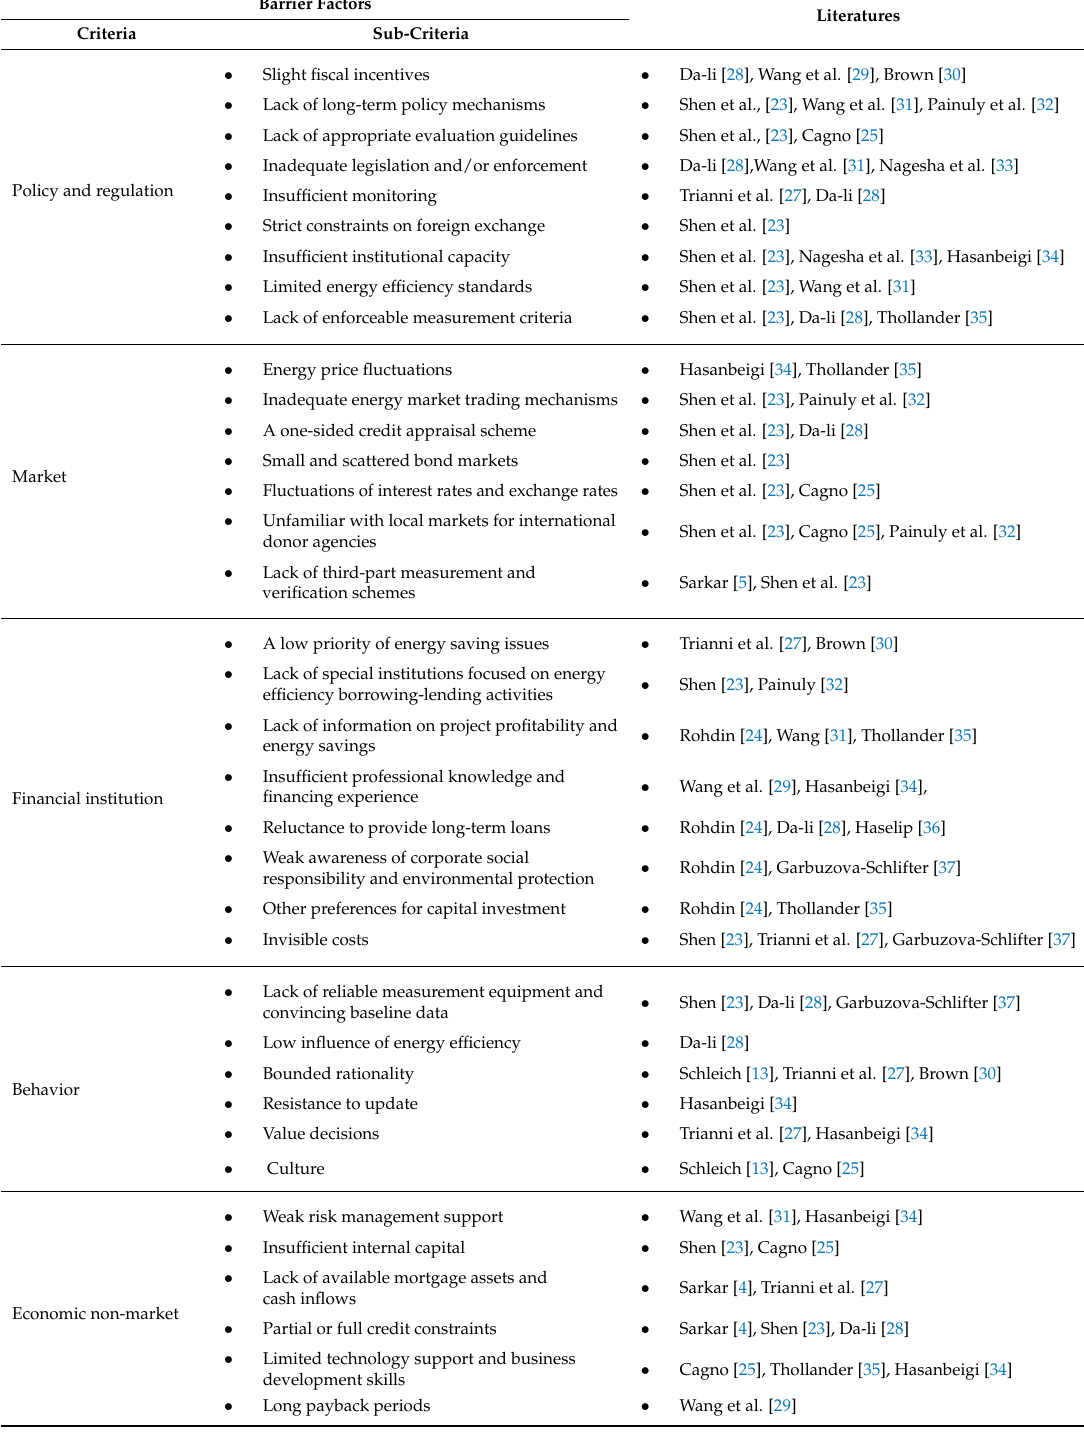
Table 1. A summary of barriers of energy efficiency financing for SMEs based on